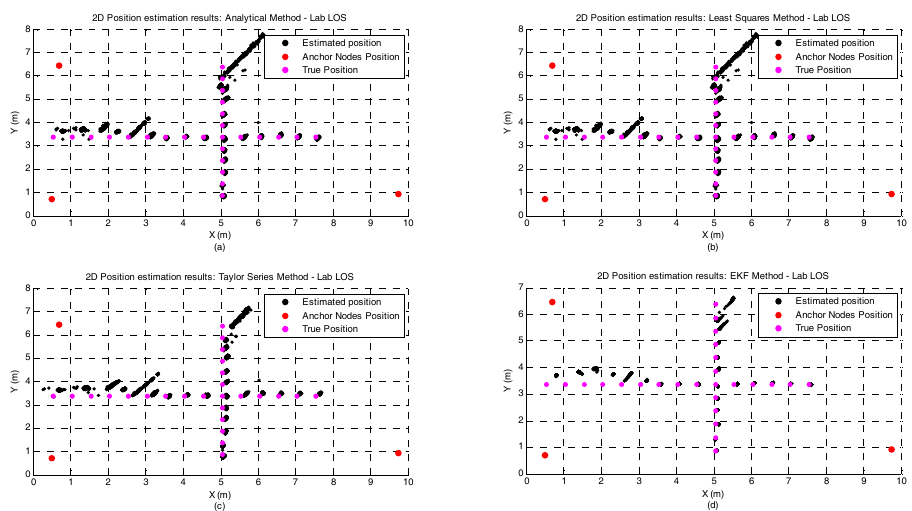
Figure 5. Graphical illustration of the 200 position estimates for each test point in the lab scenario and without human body interference. ( a ) Analytical method; ( b ) Least Squares method; ( c ) Taylor Series Method; and ( d ) EKF Method.